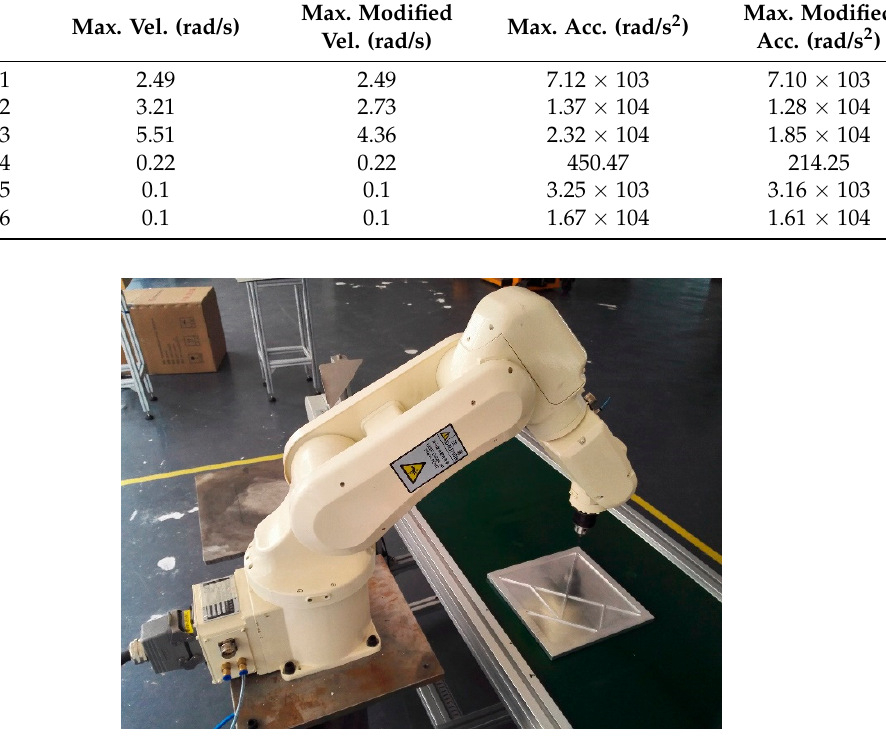
Figure 5. A machined workpiece.